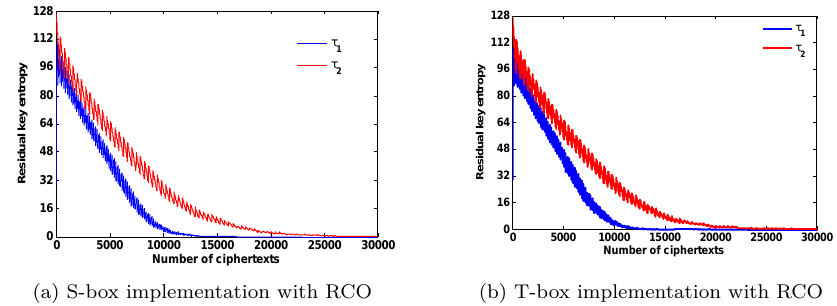
Figure 9: φ 1 ( n ), φ 2 ( n ) v.s. the number of samples, when different thresholds ( τ 1 , τ 2 ) are used in PFA on IDDMR countermeasures. φ 1 ( n ) =